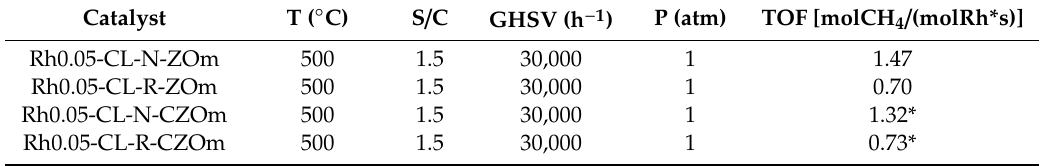
Table 2. Turnover frequency of the catalysts investigated in this work. * Calculated on the initial conversion. Catalyst T ( ◦